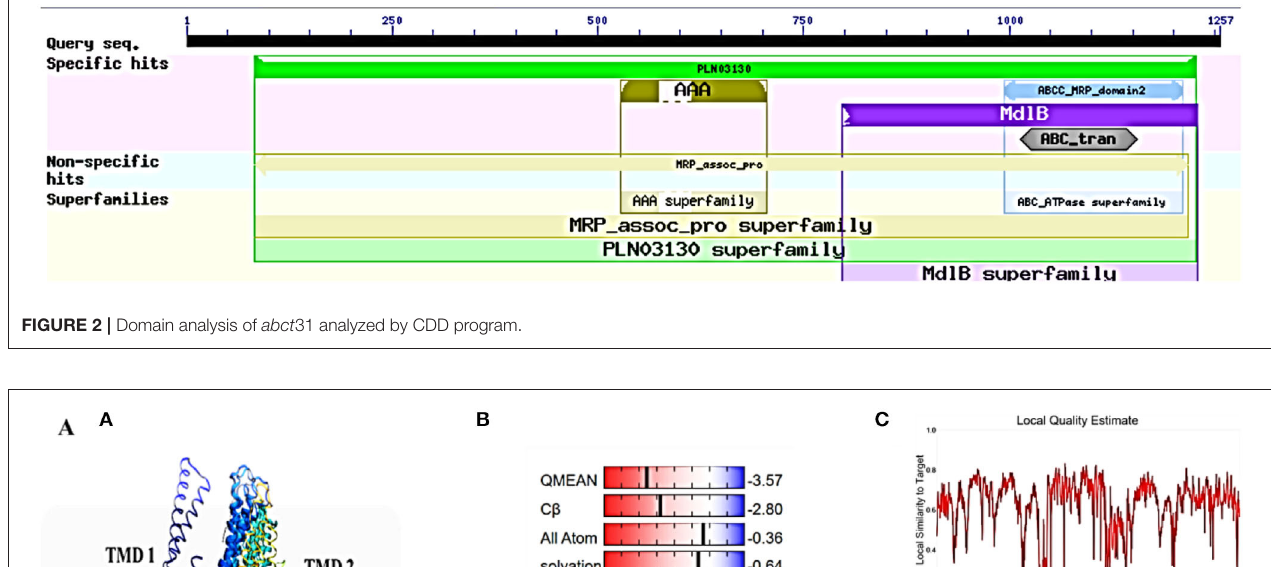
2006), and a key component of ABC transport proteins and its recognition is conserved by the low E values ( Figure 2